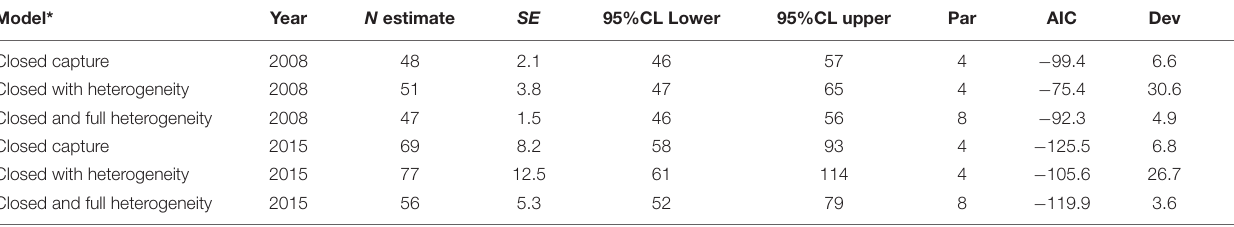
TABLE 4 | Closed mark recapture abundance estimation models 2008 and 2015 based on Otis et al.,